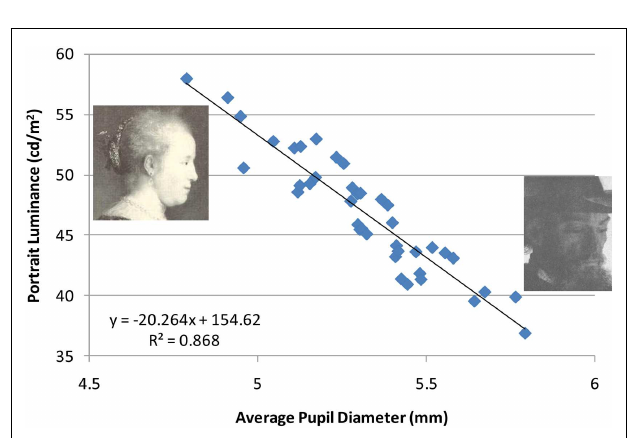
FIGURE 5 | Correlation between pupil diameter given the average luminance for each portrait ( n = 40 observers) .The figure includes the portraits with the highest and lowest average